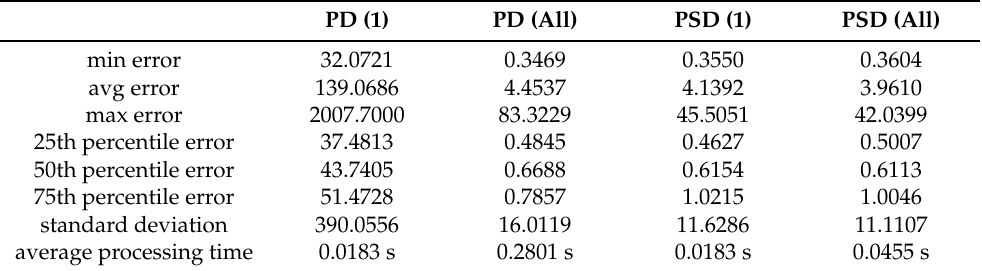
Table 3. Efficiency of modeling-based traffic prediction for WASK dataset.